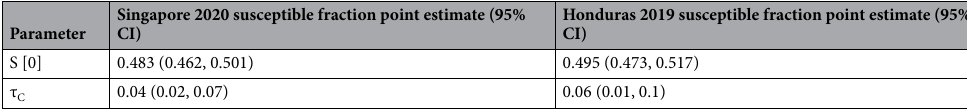
Table 1. Estimates of parameters from large-outbreak fit years for the null model.